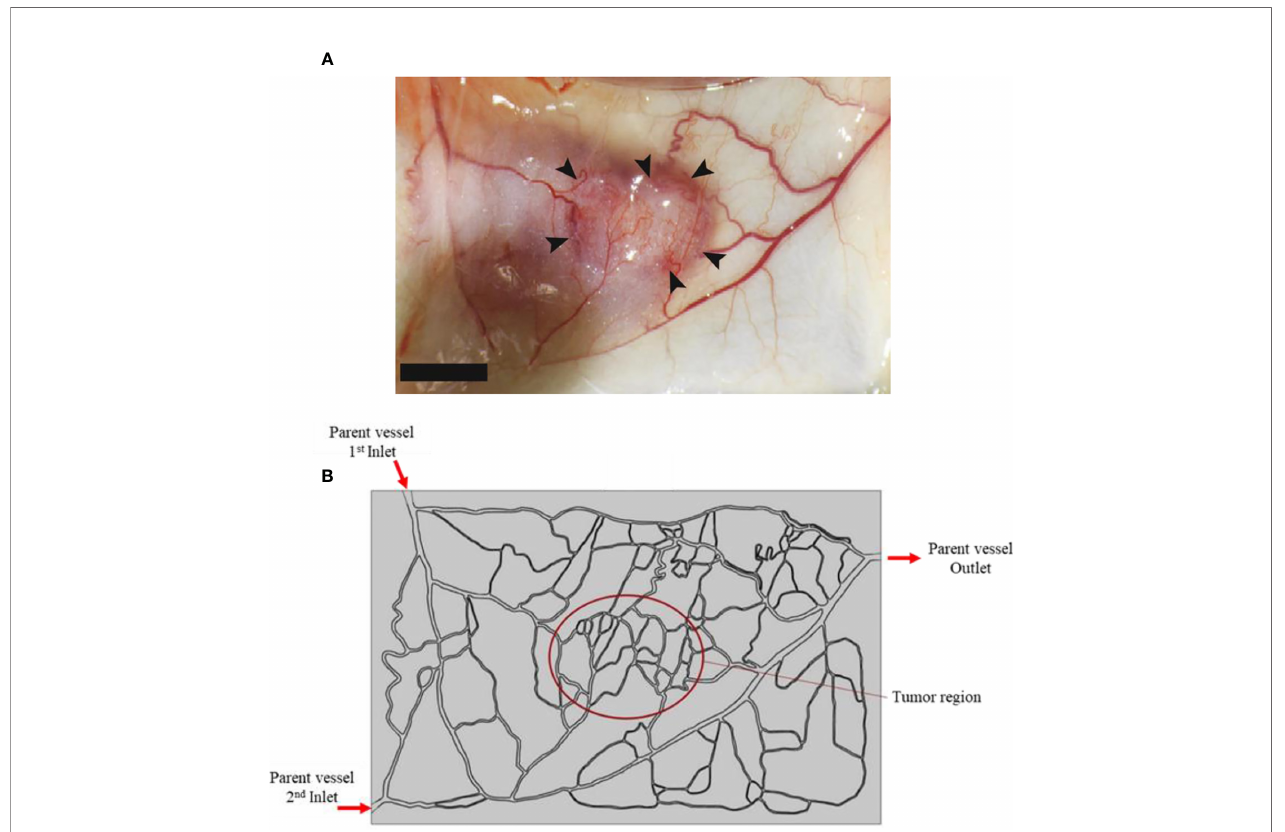
FIGURE 3 | (A) Real image of tumor, and (B) computational fi eld considered in numerical simulation which is obtained by image-processing of realistic